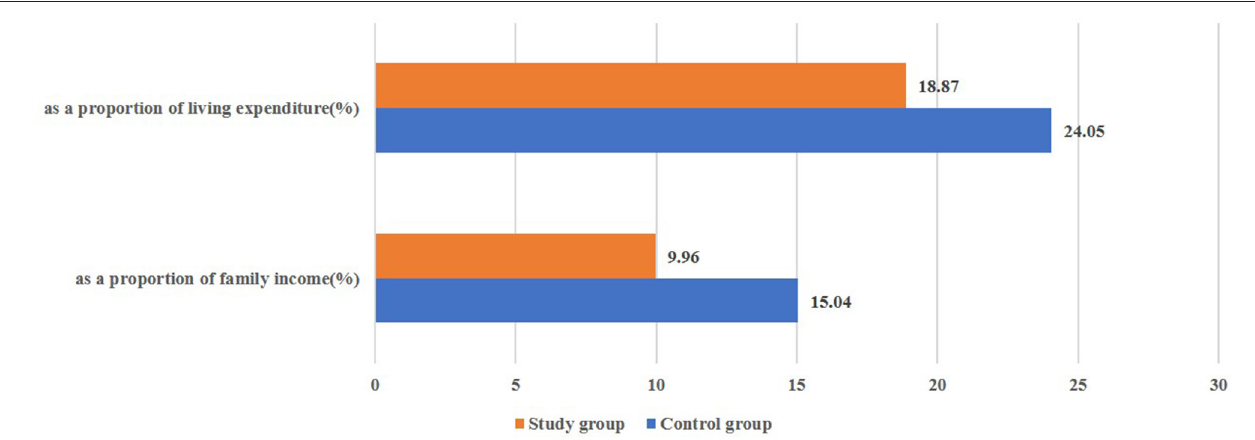
FIGURE 2 | The proportion of annual health expenditures for the two groups (%).